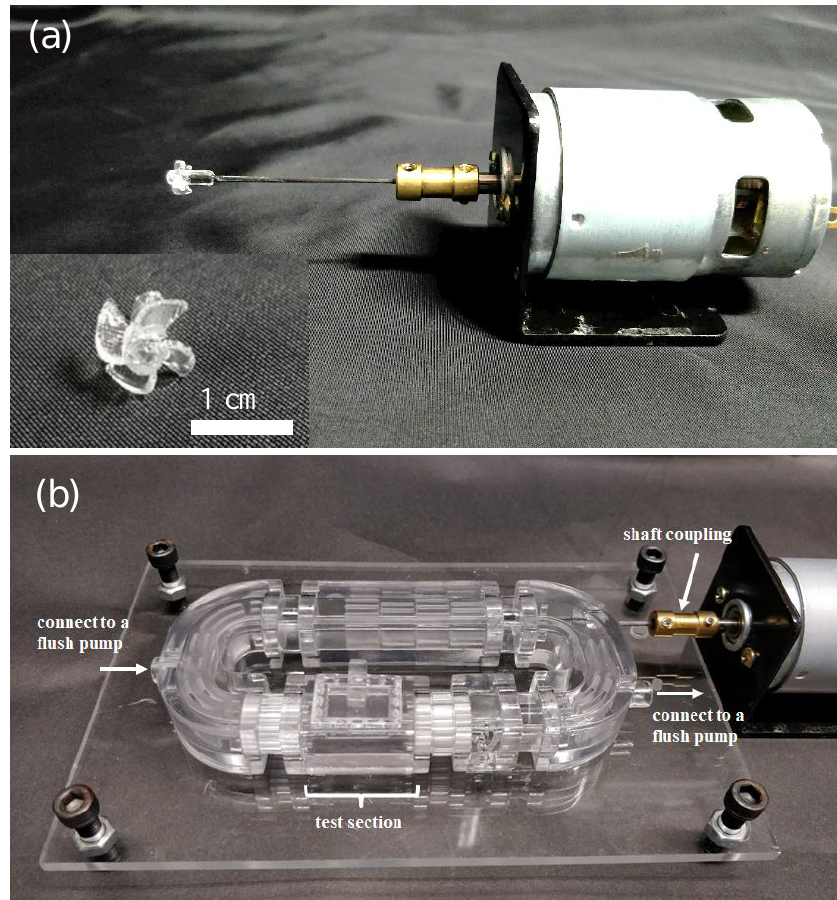
Figure 3. ( a ) Image of the 3D-printed 4 blade propeller, which was mounted on a 3 mm diameter shaft and connected to a DC motor via a shaft coupling. ( b ) The 3D-printed propeller was assembled into a 3D-printed zebrafish treadmill with a fixing structure at the C-shaped channel to support the shaft and avoid shaft vibration.